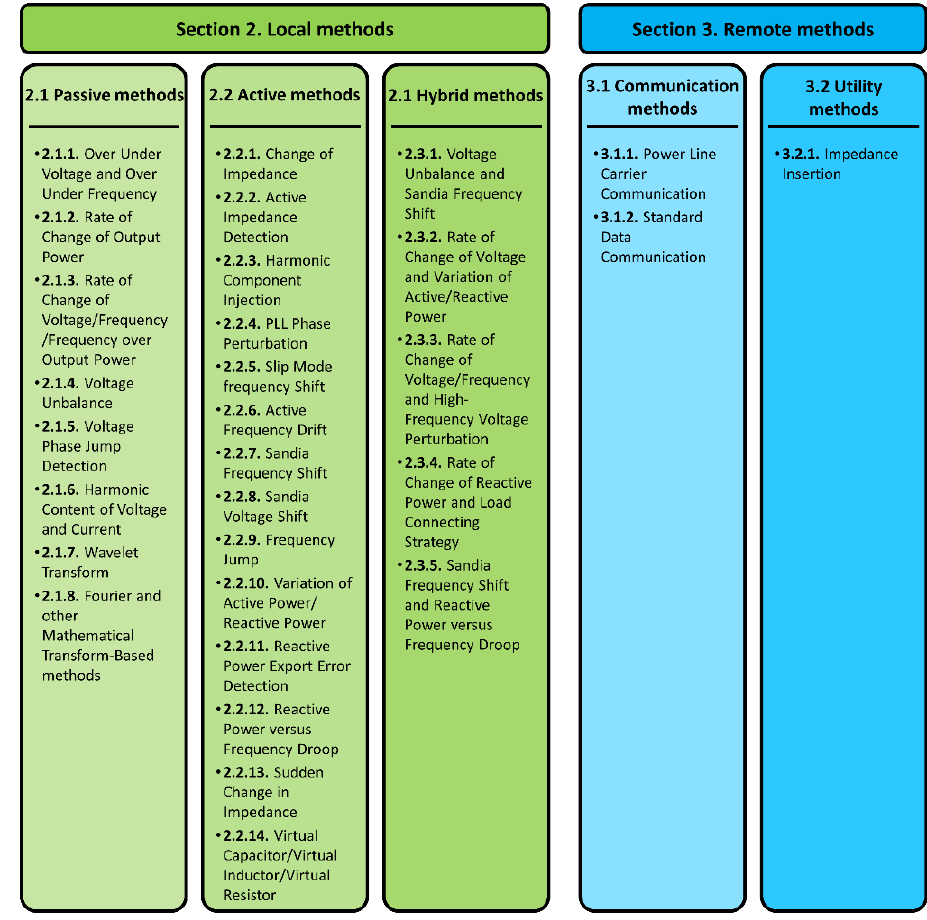
Figure 1. Classified list of the islanding methods evaluated in this work.